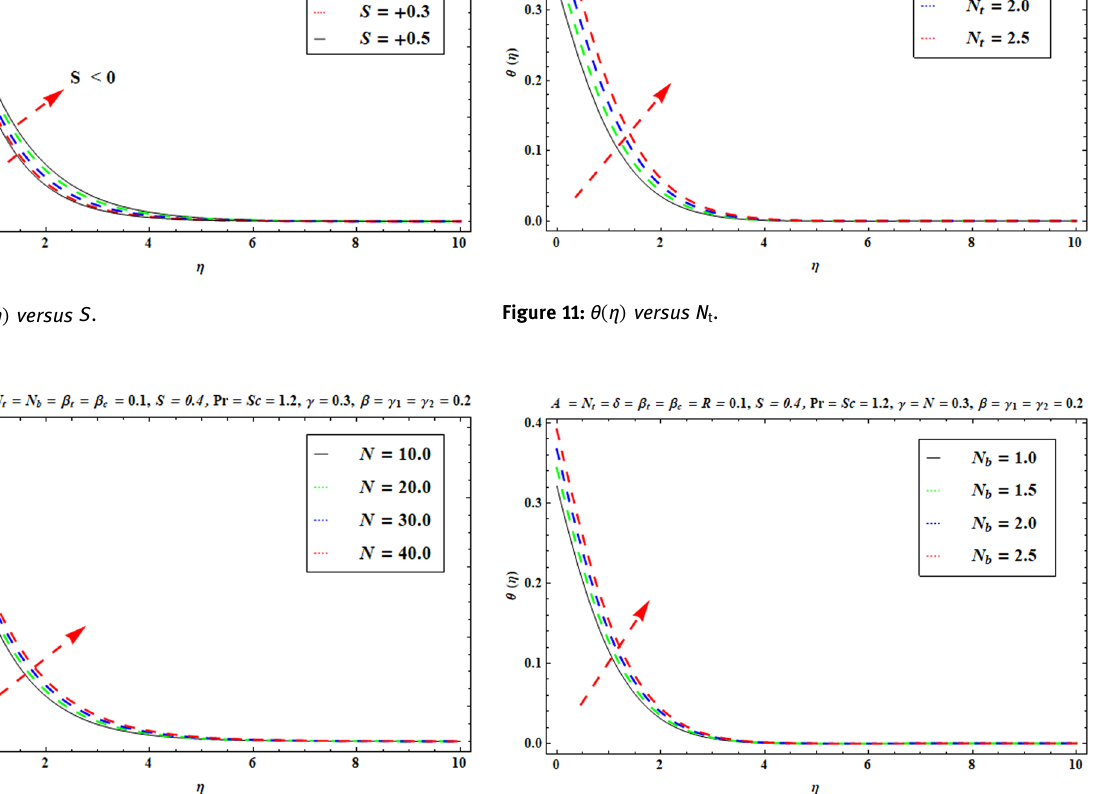
Figure 12: θ η ( ) versus N .